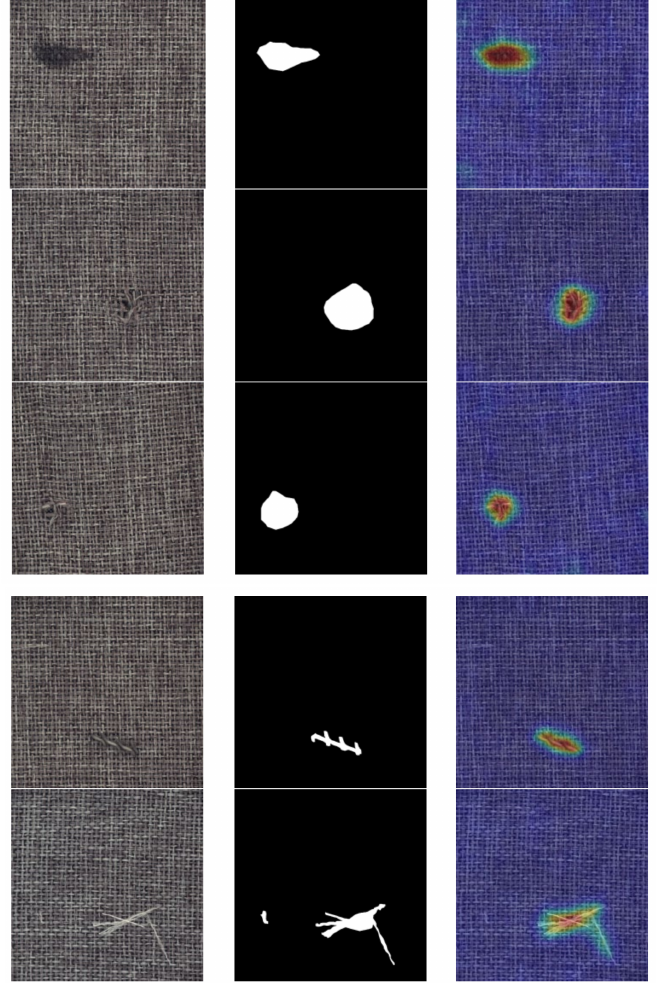
Figure 5. Inspection results of our proposed method using the carpet dataset. The first row to the last row represent the color, cut, hole, metal_contamination, and thread defects, respectively. The first column is the original image, the second column is the ground truth, and the third column is an anomaly